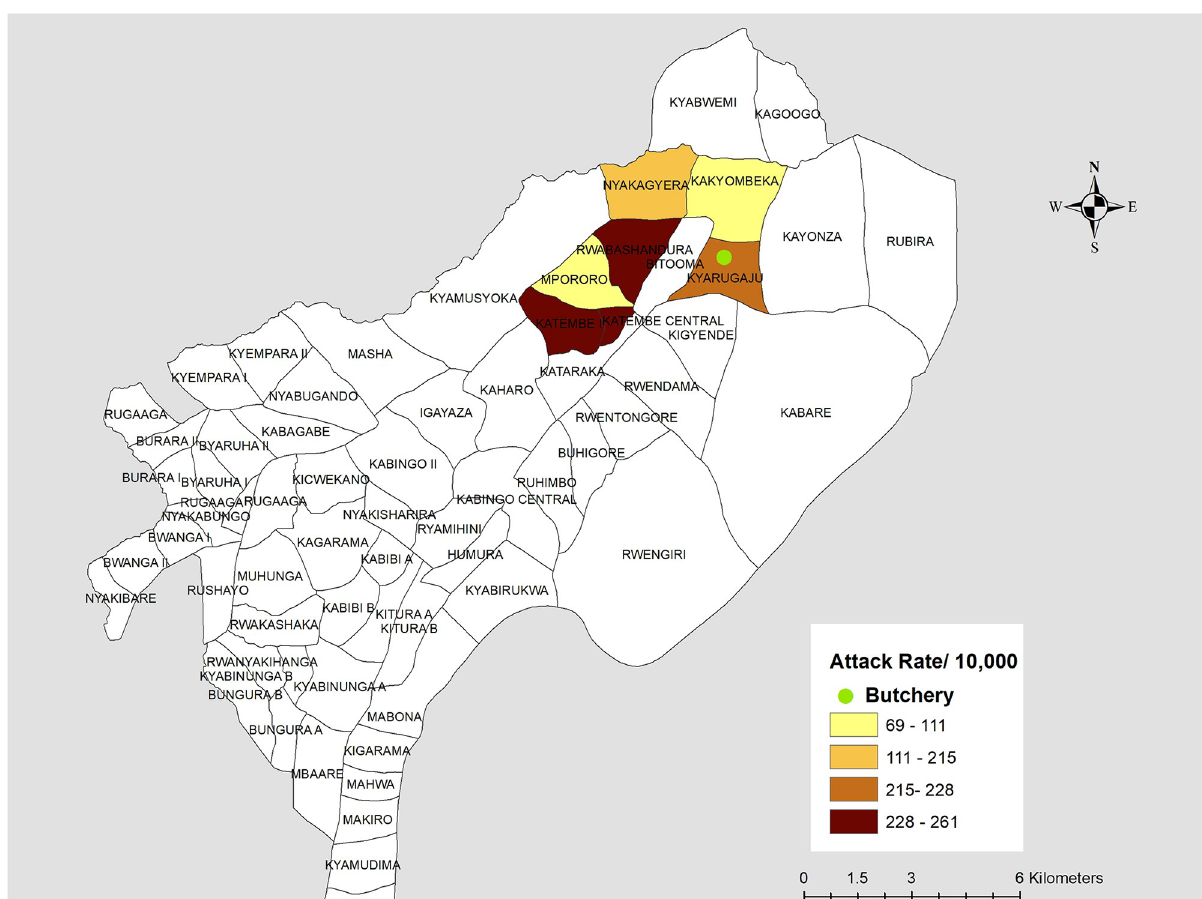
Fig 1. Attack rates by villages in Kabingo subcounty, Isingiro District, Uganda, August 2017 (map drawn using QGIS browser 2.8.2).